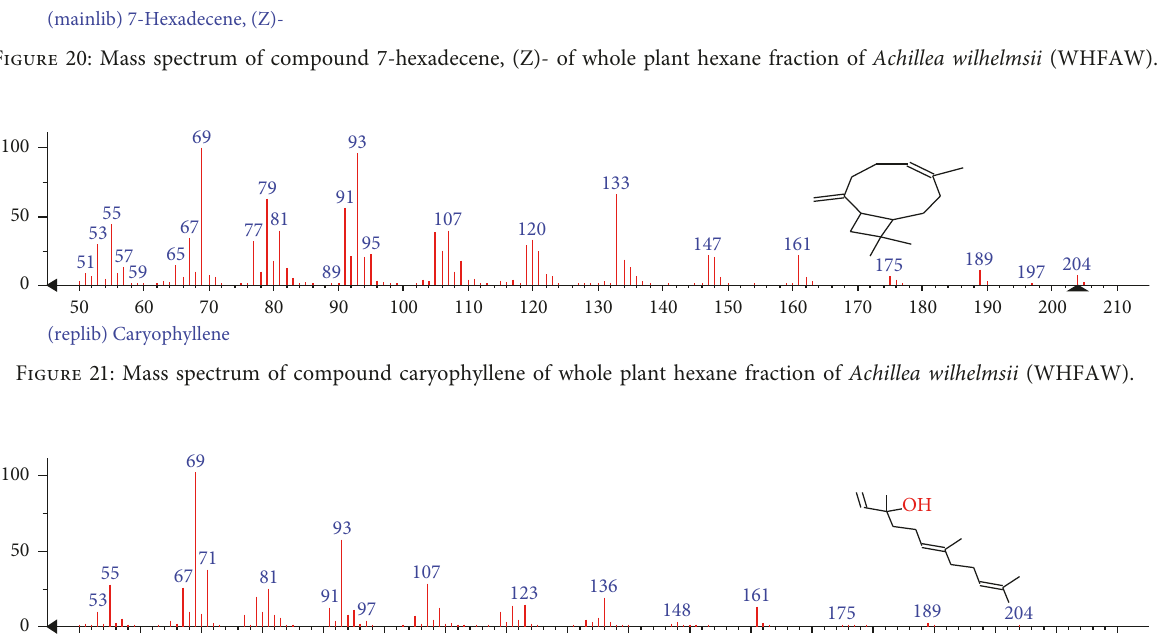
(E)-50 60 (mainlib) 1,6,10-Dodecatrien-3-ol, 3,7,11-trimethyl-, Figure 22: Mass spectrum of compound 1,6,10-dodecatrien-3-ol, 3,7,11-trimethyl-, (E)- of whole plant hexane fraction of Achillea wilhelmsii (WHFAW).